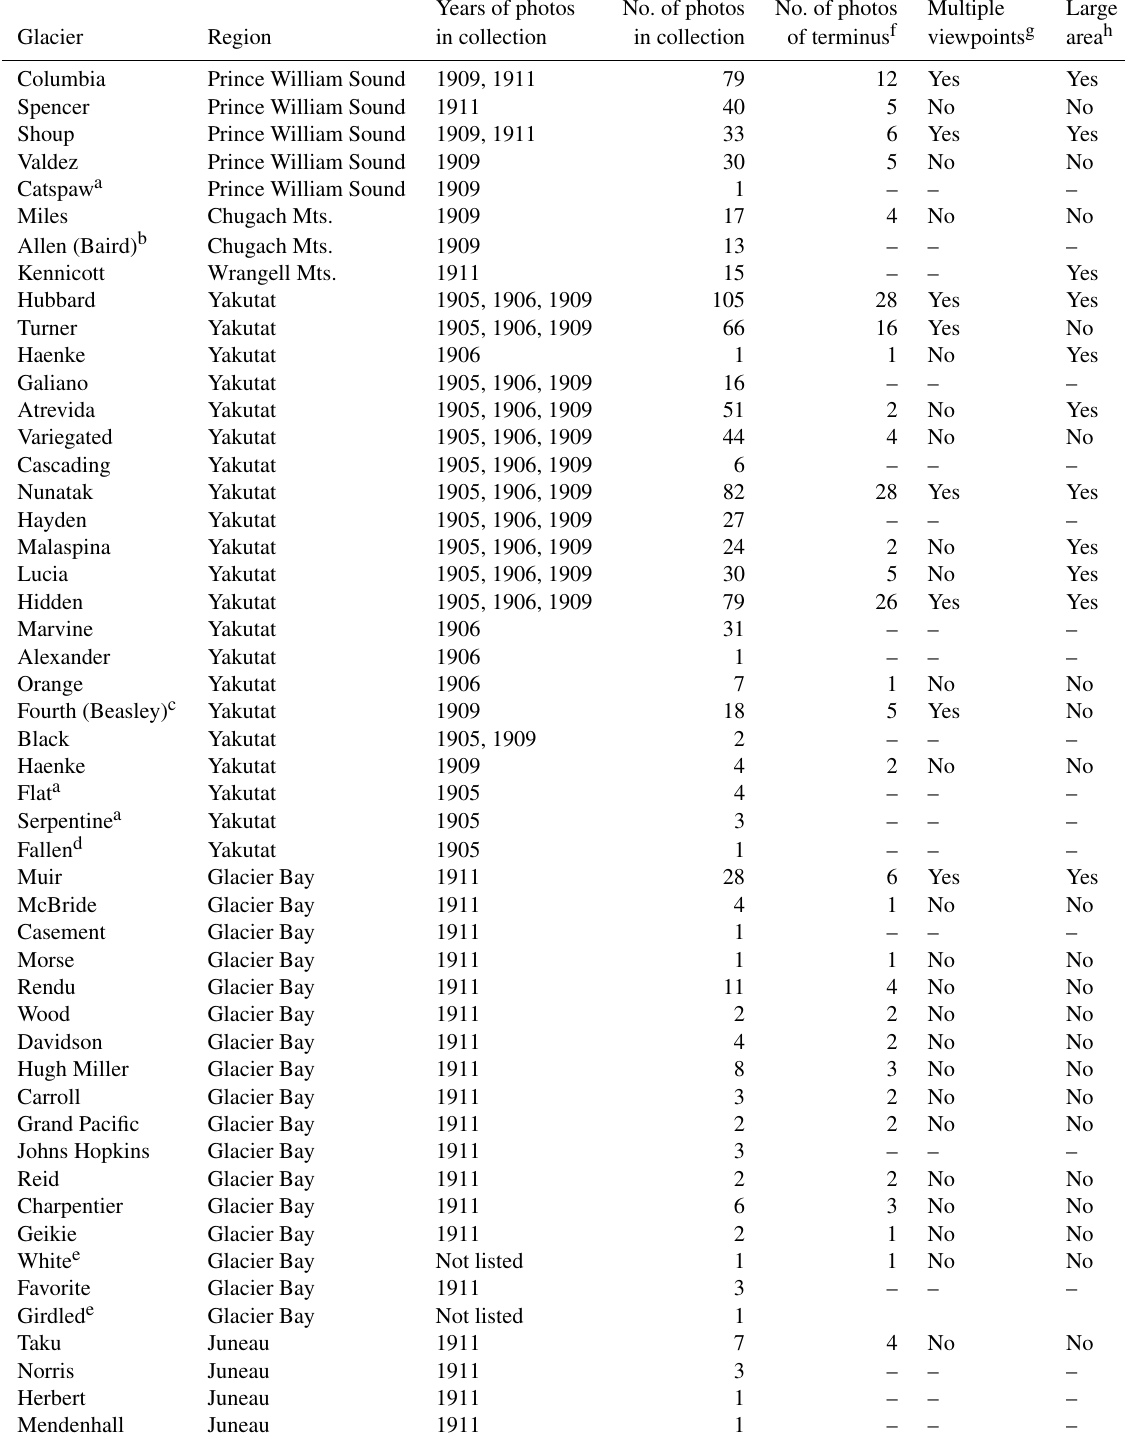
Table 2. Alaska glacier photographs in